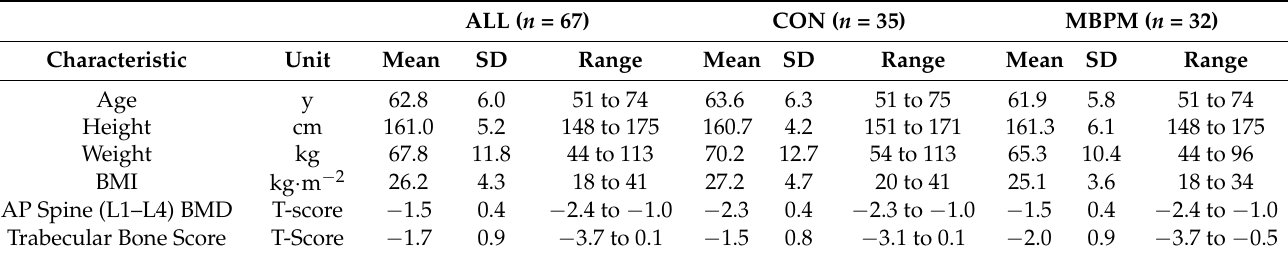
Table 1. Subject population ( n =